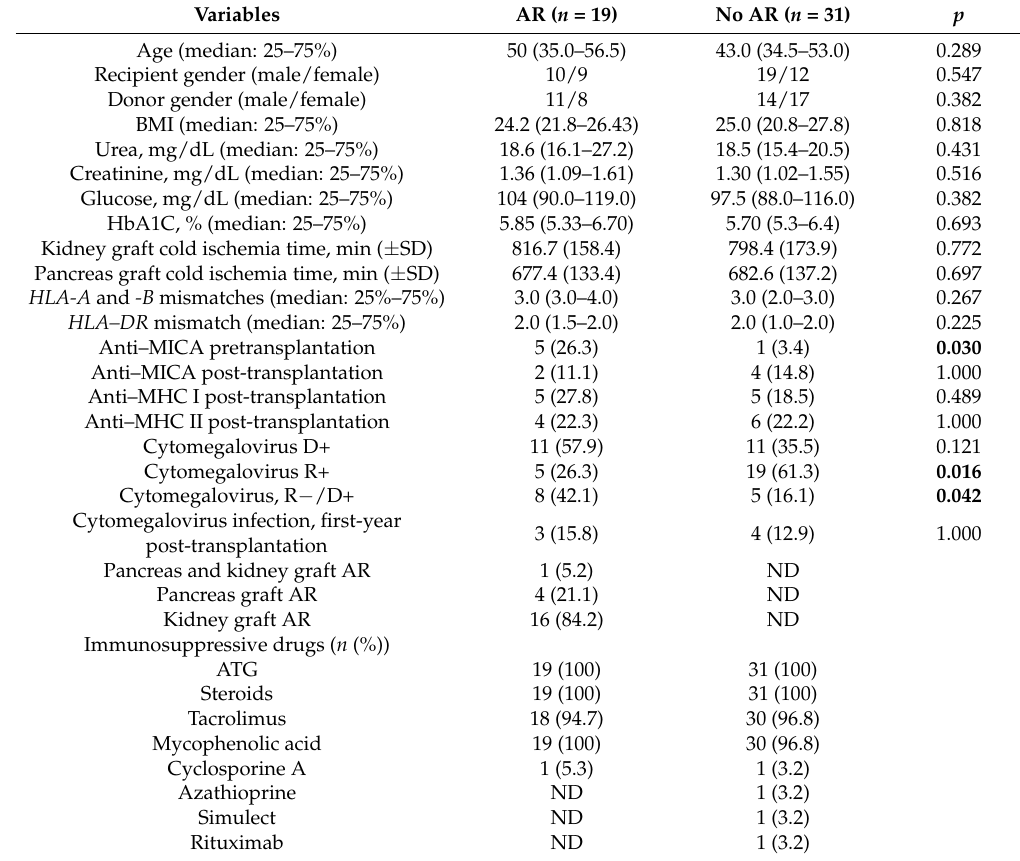
Table 1. Clinical and demographic characteristics of SPKT patients stratified by the presence of AR in the first year